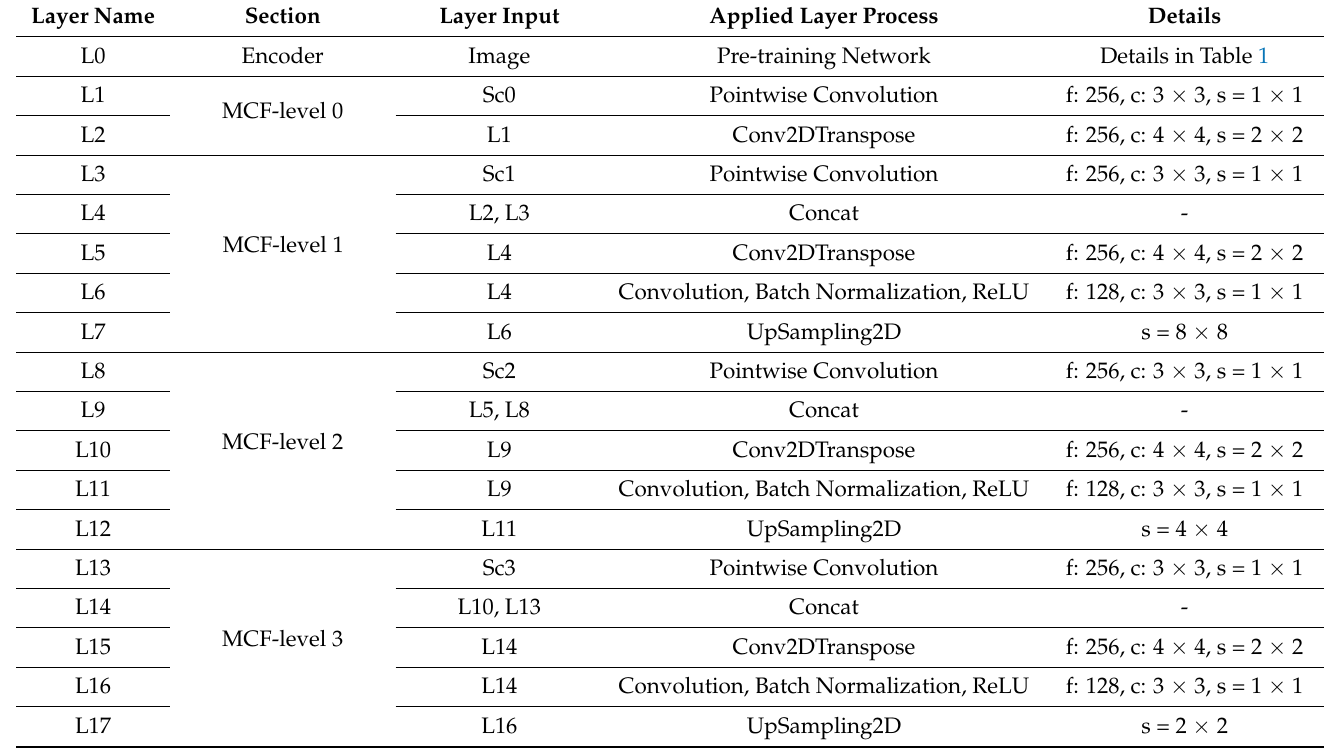
Table 2. Detailed layer structure and connections (layer inputs) of the DCDNet model (Sc: skip connection, f: filters, c: kernel, s: